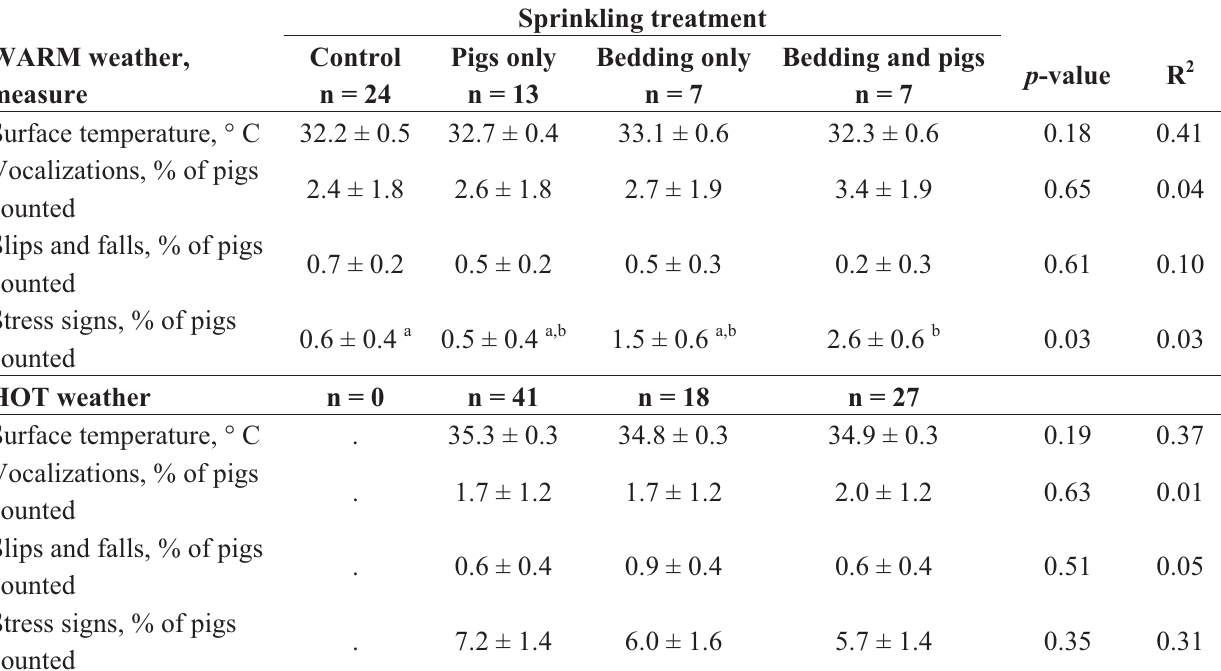
Table 1. Experiment 1. Effects of sprinkling 1 on pig measures 2 in market weight pigs in WARM 3 and HOT 4